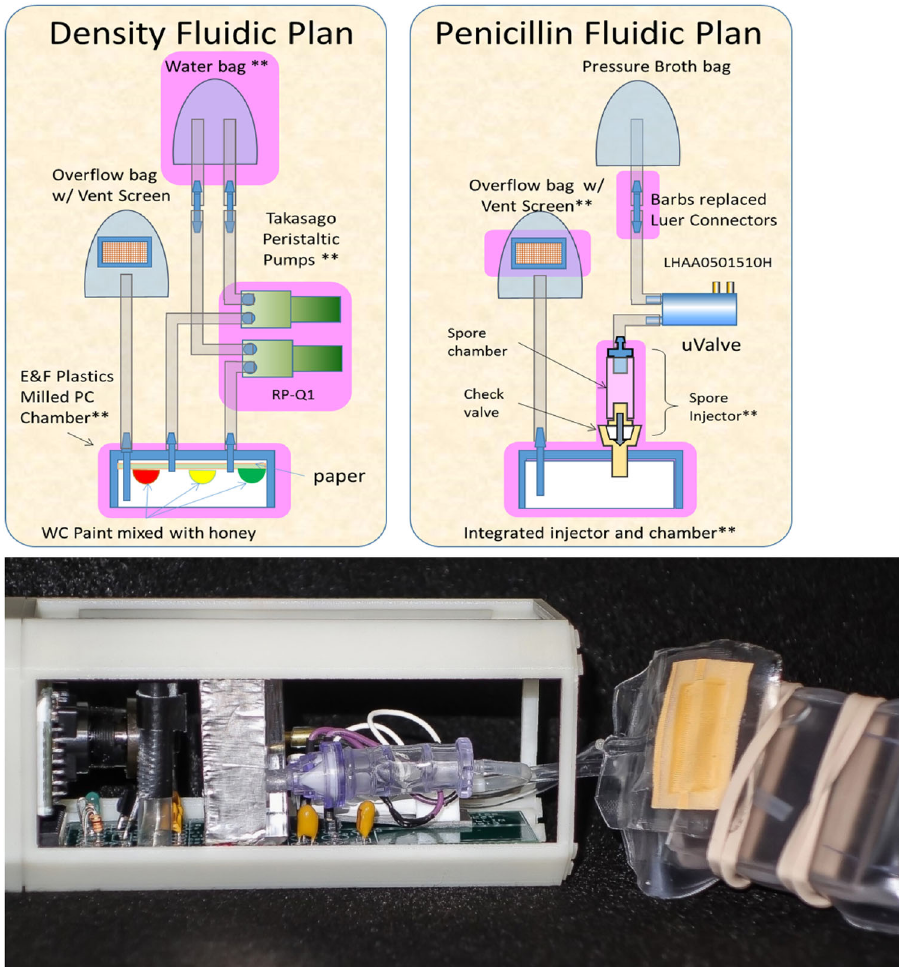
Fig. 5 Rapid prototyping innovations of fl uidic density and penicillin